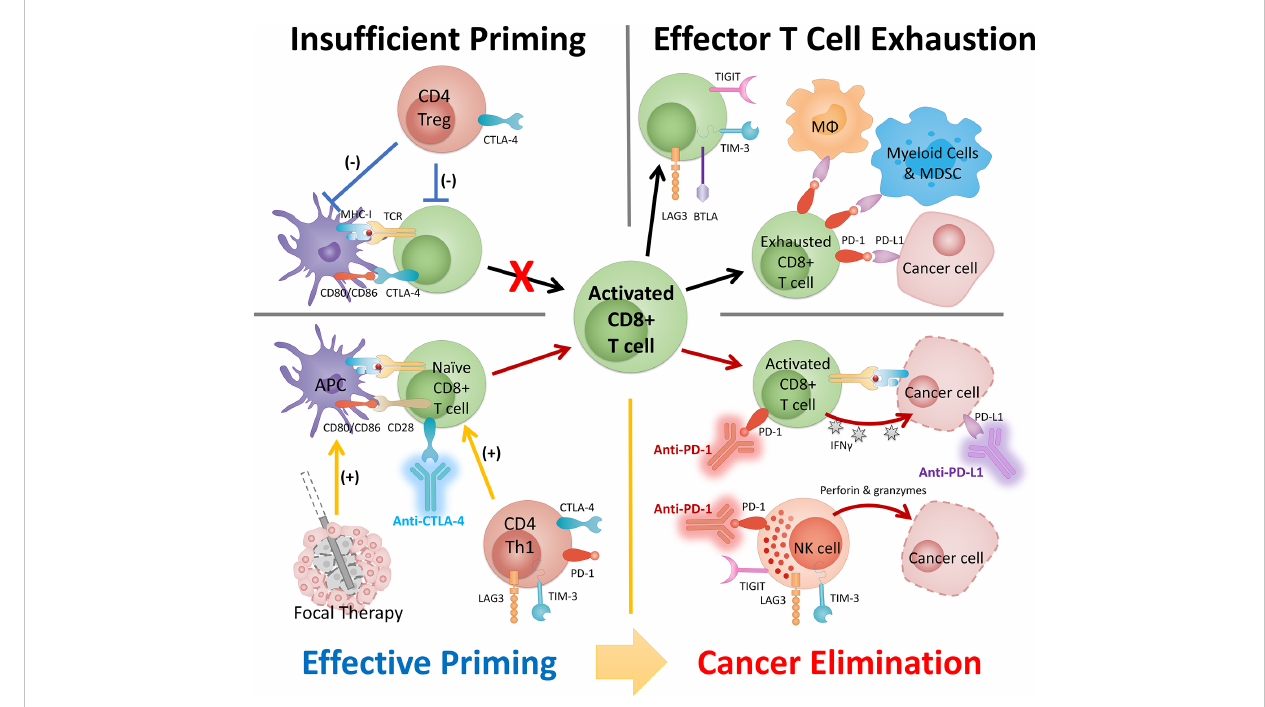
FIGURE 2 The synergy between FT and ICI serves as the basis of a combinatory approach in cancer management. The success of this combinatory strategy relies heavily on the activated CD8 T cells (i.e., population, location, and phenotype). The status of CD8 T cells is dictated by the cancer property (e.g., tumor type) and disease status and can be strongly modulated by intervention. Insuf fi cient priming can be addressed by focal therapy and early intervention of anti-CTLA-4 and other ICI targeting Th1 CD4 T cells. T cell exhaustion can be mitigated by careful engineering of FT and ICIs (primarily anti-PD-1/PD-L1) that targets pathways preventing T cells to eliminate cancer. MDSC, myeloid-derived suppressor cells; M F ,